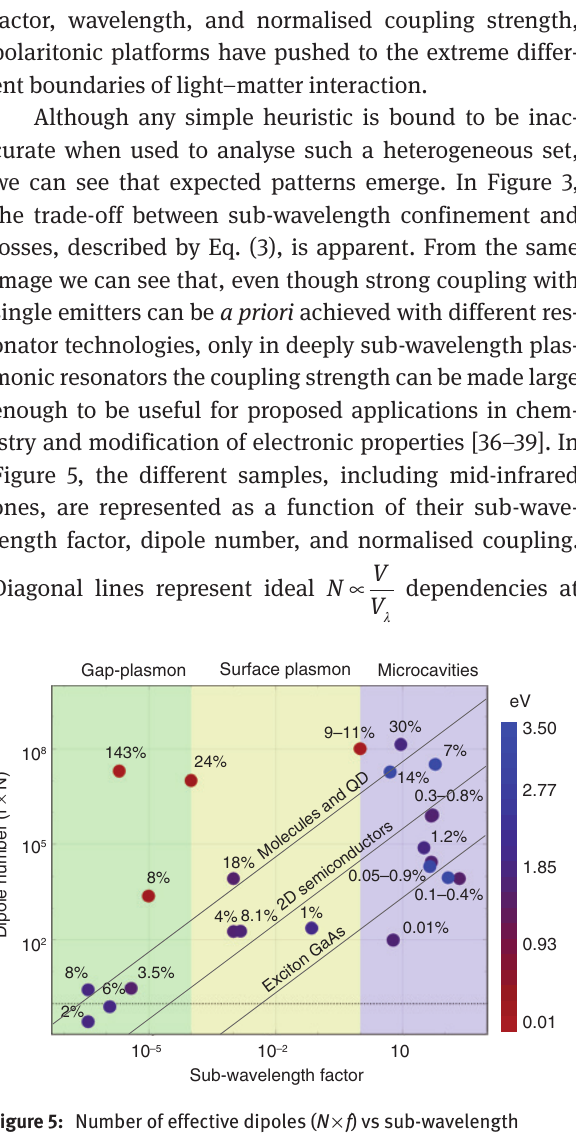
Figure 5: Number of effective dipoles ( N × f ) vs sub-wavelength confinement factor as reported in Tables 2–4.The normalised coupling η is shown in the label on each point. The vertical shaded regions indicate the sub-wavelength range for dielectric microcavities (purple), plasmonic surface modes (yellow), and extremely localised plasmonic nanoantennas (green). The energy of the electronic resonance is shown for each point by the color code on the right of the figure. The grey lines represent the scaling of volume and dipole number, at a given frequency and constant η . Given that the dipole density is roughly constant for each materials, each line represents increasing light–matter interaction going from the bottom-left corner to the top-right corner. The horizontal line indicates the unitary strength of an ideal single electronic oscillator, N × f =